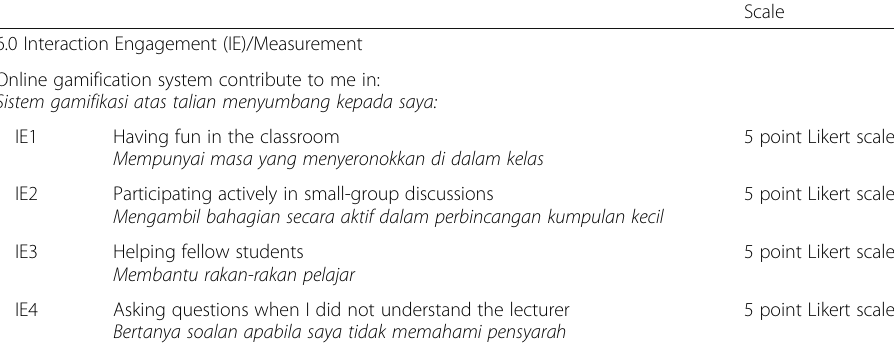
Table 2 Survey items (Continued)